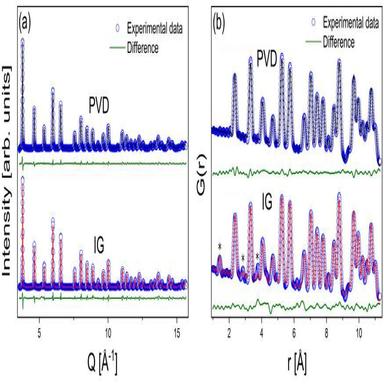
(a) Neutron diffraction data (blue) and corresponding fits from Rietveld refinement for ZrC synthesized with IG (red) and PVD (black) methods. (b) Neutron PDF data (blue) and small-box refinement results from 1.0 to 11.3 A˚ for ZrC synthesized with IG (red) and PVD (black) methods. A local modified graphite phase is evident in the PDF of the IG sample by the pronounced correlation at 1.42 A. ˚ Green lines represent in all plots difference curves between experimental data and structural refinement. ∗ denotes